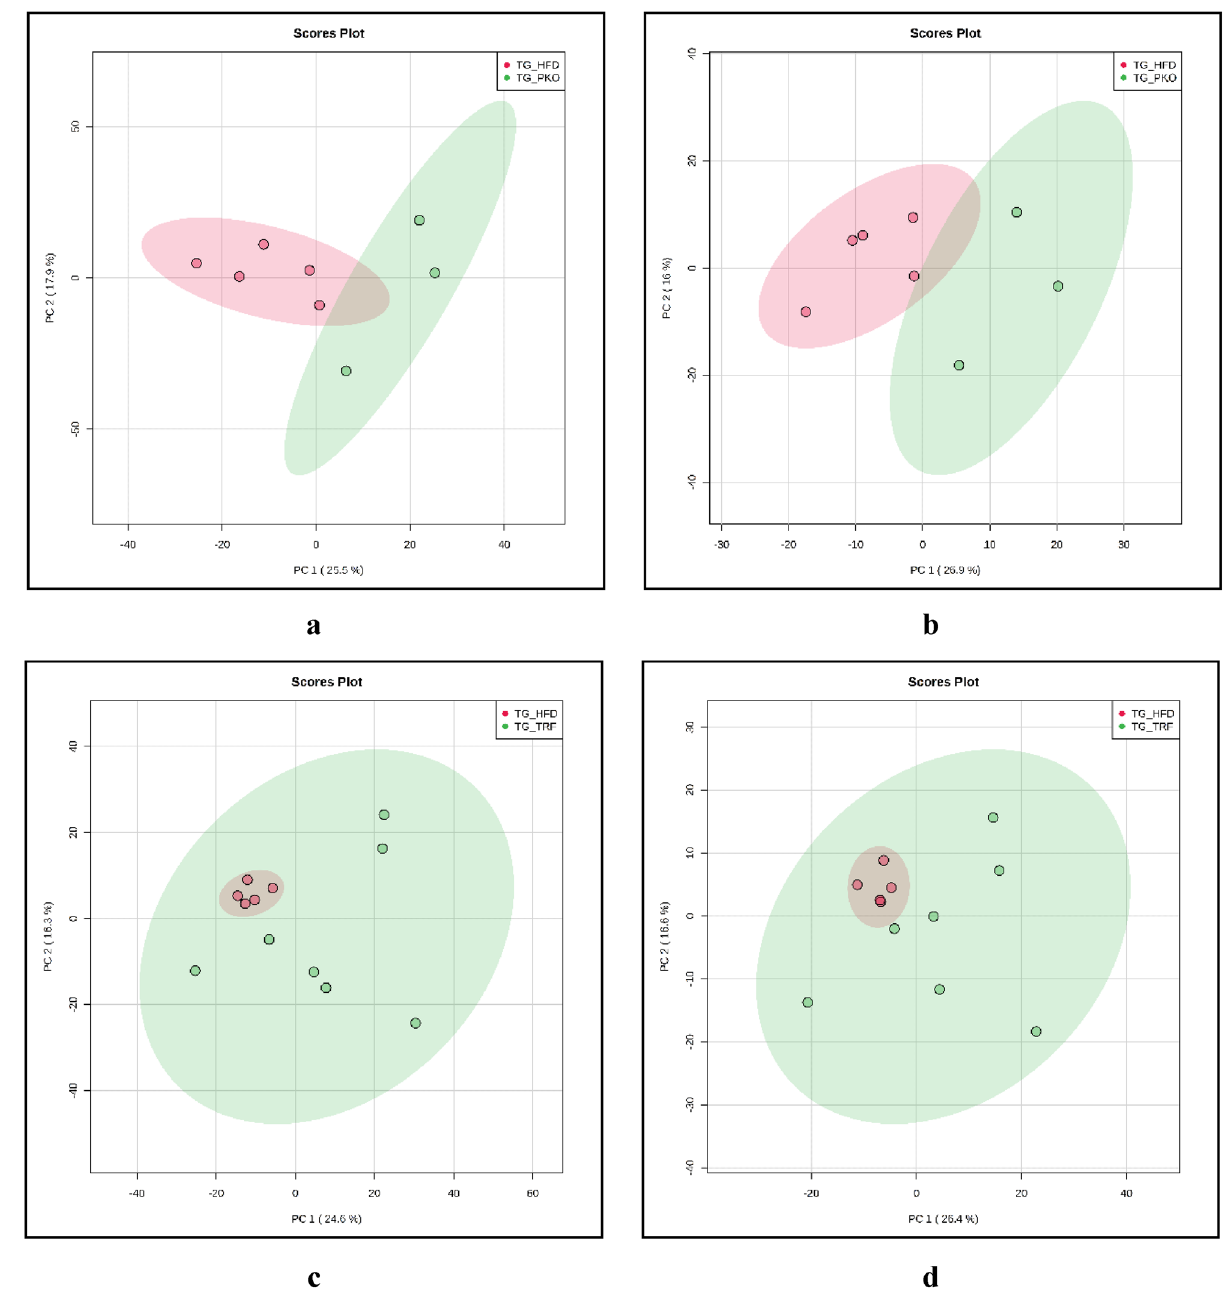
Figure 1. PCA score plots between PKO (green filled circle) and HFD (red filled circle) in positive mode ( a ) and negative mode ( b ), PCA score plot between TRF (green filled circle) and HFD (red filled circle) in positive mode ( c ) and in negative mode ( d ), PCA score plot between ETRF (red filled circle) and HFD (green filled circle) in positive mode ( e ) and negative mode ( f ), PCA score plot between ETRF (red filled circle) and TRF (green filled circle) in positive mode ( g ) and negative mode ( h